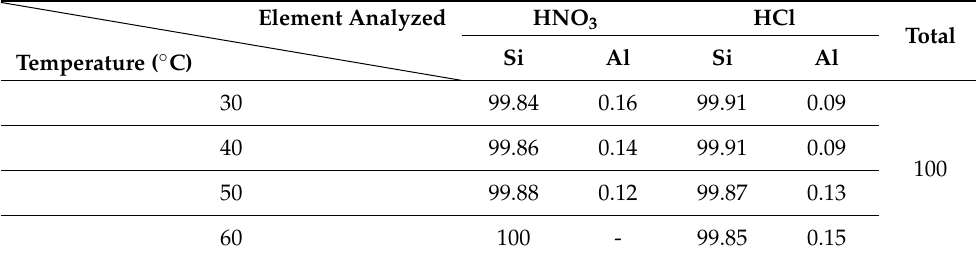
Table 4. XRF analysis results of a dried photovoltaic cell—temperature (unit: wt.%). Element Analyzed Temperature ( ◦